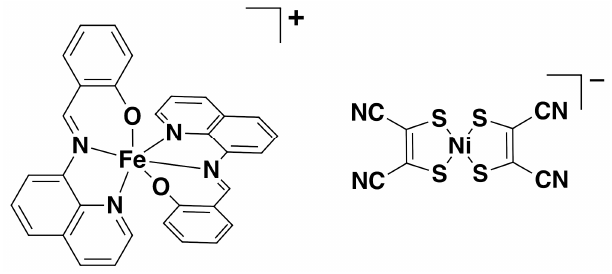
Figure 1. Chemical structural formula of compound 1 .